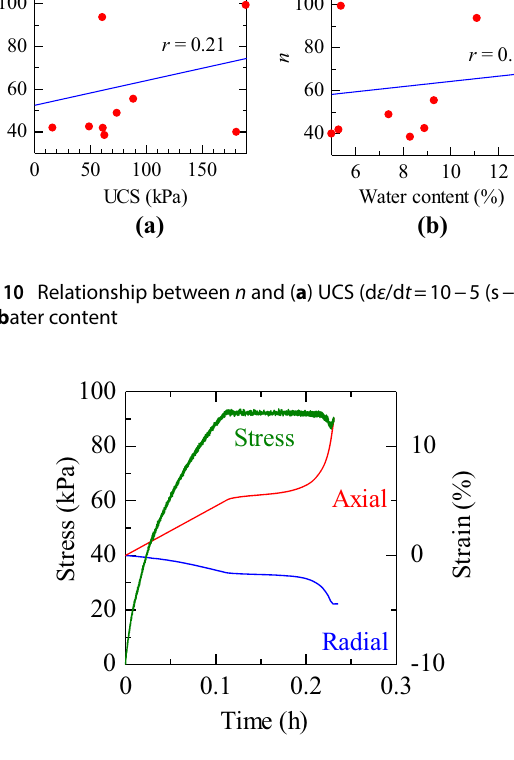
Fig. 11 Example of the results of the uniaxial creep